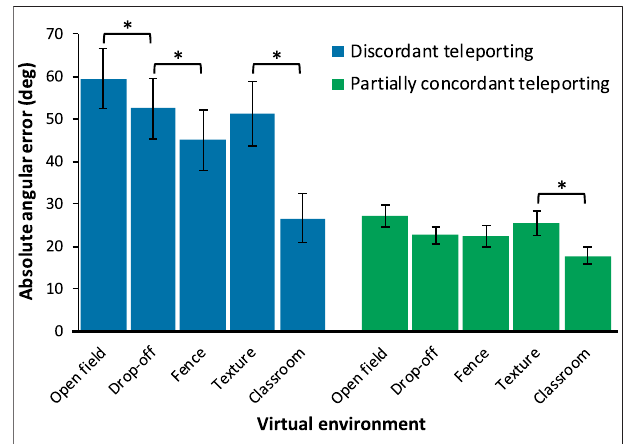
FIGURE 3 | Mean untransformed absolute angular error shown separately by condition. Higher values correspond to greater error (i.e., worse performance). Error bars represent +/ − 1 SEM. Asterisks represent signi fi cant differences using repeated contrasts. Note that not all possible pairs were tested, see Section 3.1 for